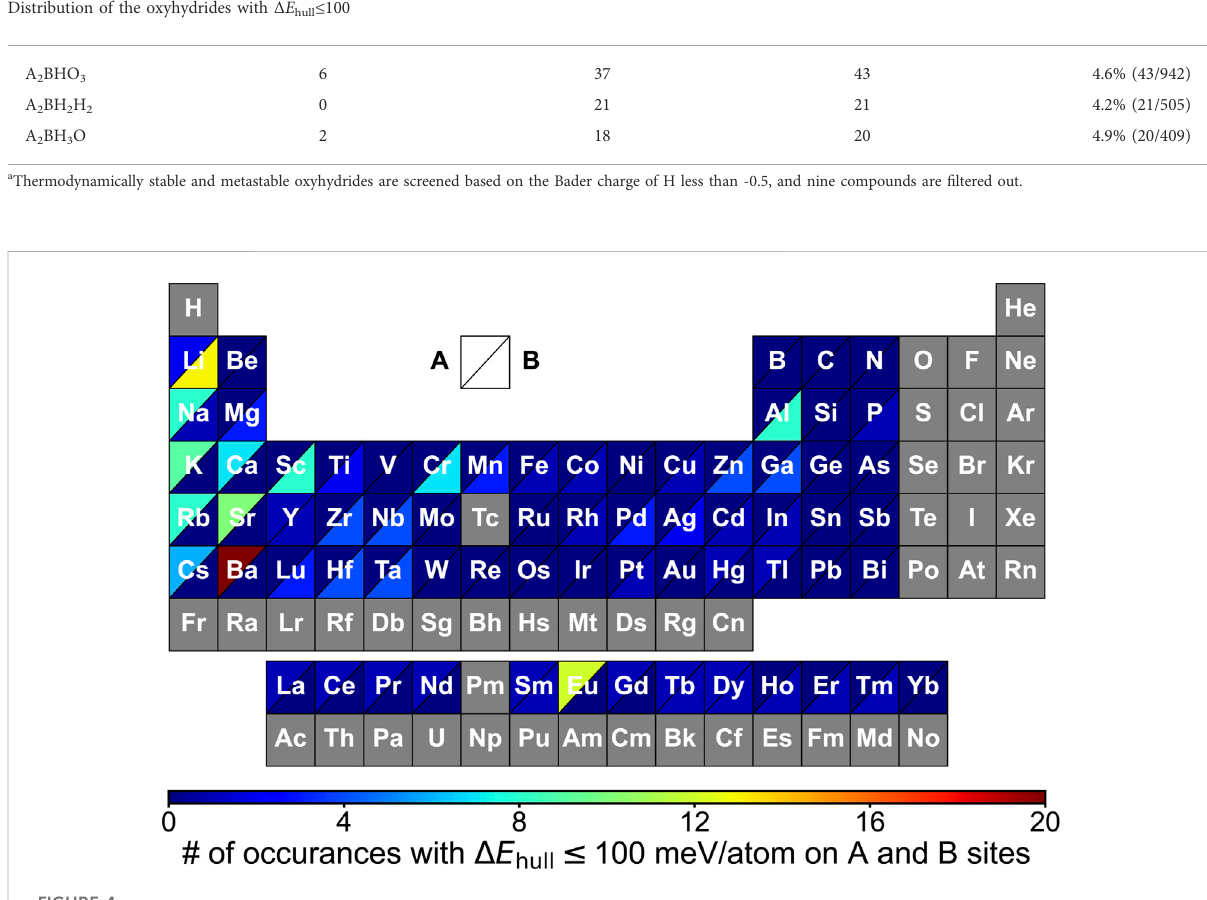
FIGURE 4 Periodic table showing the frequency of elements in A 2 BH 1+ x O 3- x ( x = 0, 1, 2) oxyhydrides with Δ E hull ≤ 100 meV/atom occupying A and B sites. Each block represents an element that is colored based on the occurrences on A (upper left triangle) and B sites (lower right triangle) in the meta/ stable oxyhydrides, respectively. Elements in gray blocks are not considered in the